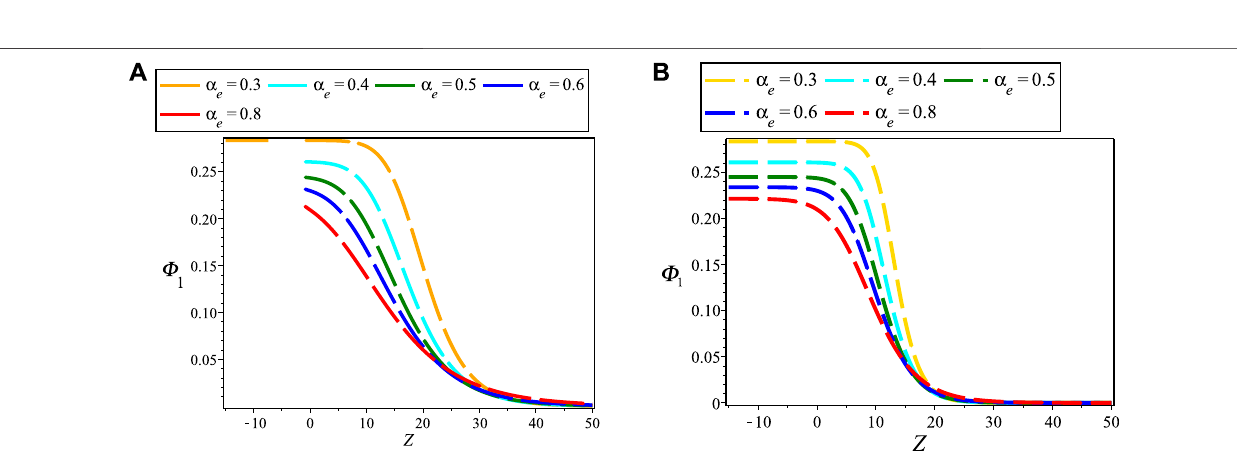
Frontiers in Physics |